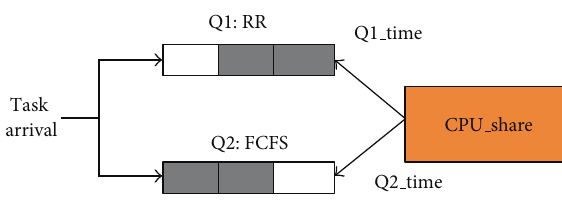
Figure 6: Schematic view of proposed